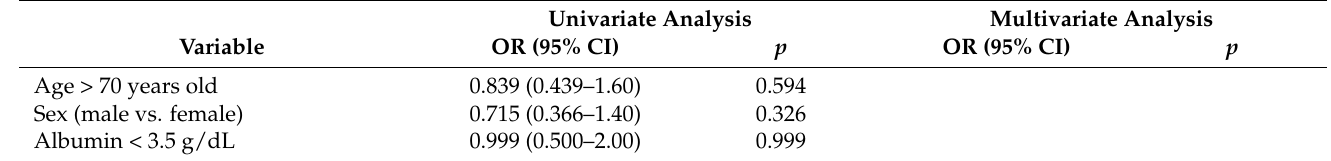
Figure 3. Differences in early recurrence and liver dysfunction rates between initial and repeat TACE. ( a ) Repeat TACE was associated with a higher risk of early recurrence in Child–Pugh class A patients with HCC within the up-to-seven criteria than in those with initial TACE. ( b ) Repeat TACE was associated with a higher risk of liver dysfunction in the transition from Child–Pugh class A to class B than in initial TACE. TACE, transcatheter arterial chemoembolization; HCC, hepatocellular carcinoma.